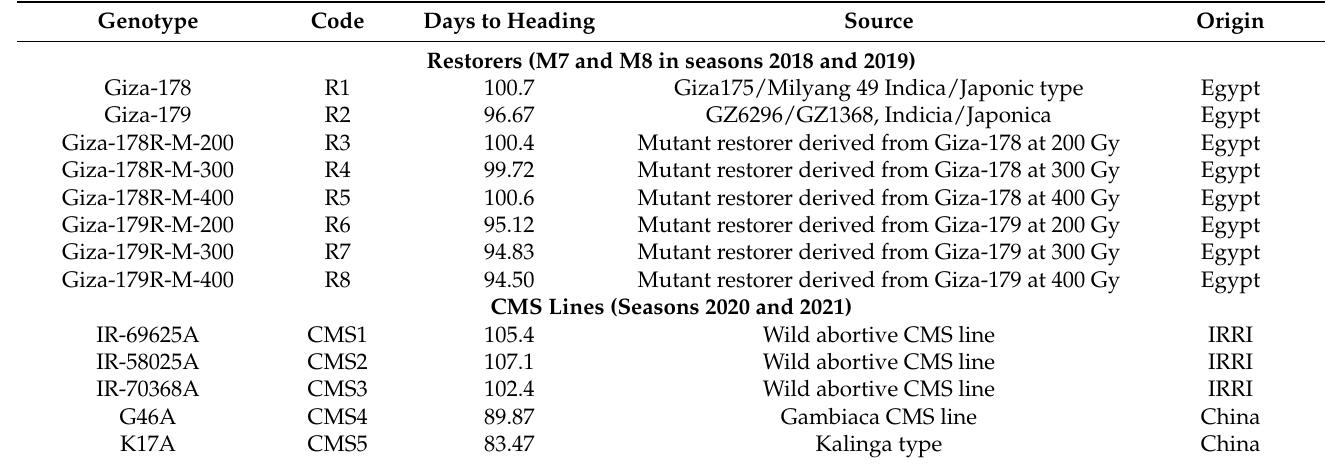
Table 1. The restorers and cytoplasmic male sterile lines were used in this